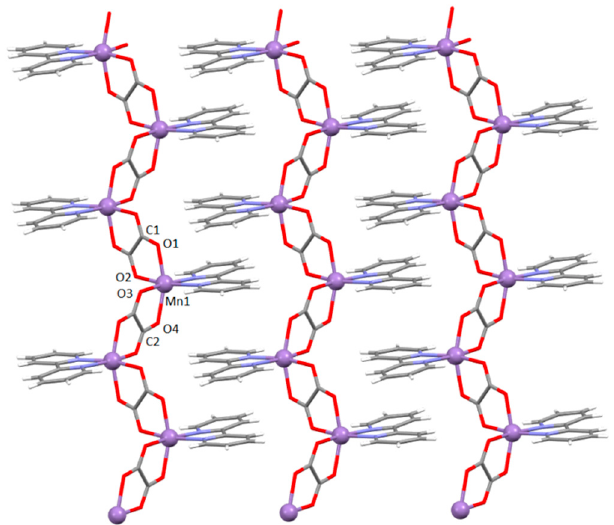
Figure 1. The 1D zigzag [Mn(bpy)(C 2 O 4 )] n chains of polymer 1 in the direction [110]. The aromatic systems of the neighbouring chains are stacked by π -interactions parallel to the plane (001).